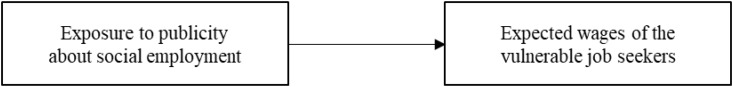
Research model 1.